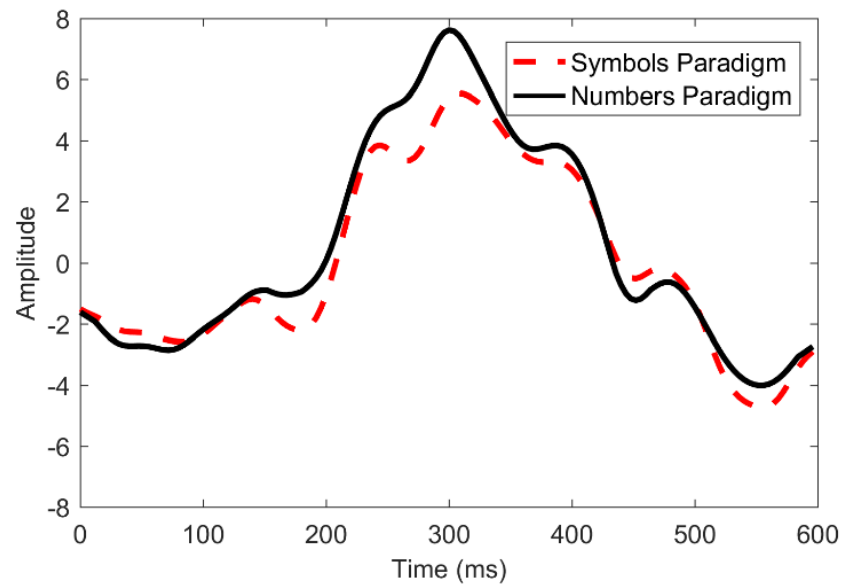
Figure 8. Comparison of the ERPs for both the displays.